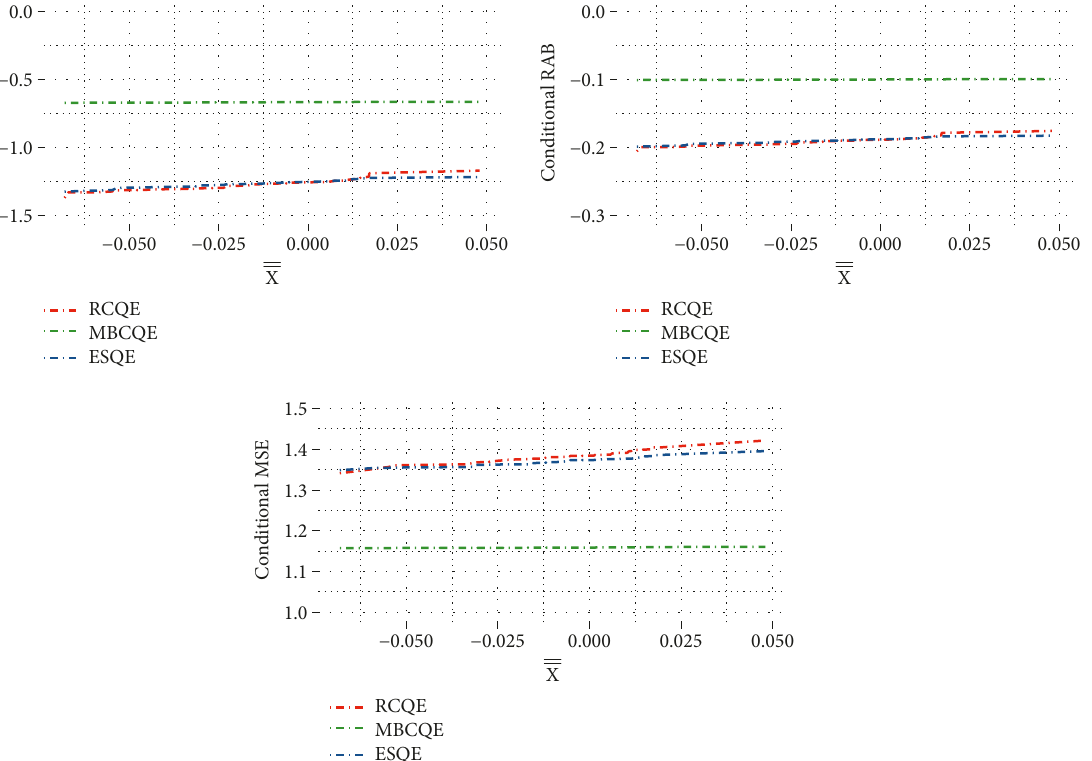
Figure 2: CB, CRAB, and CMSE for estimators: linear mean function, α � 0 . 5.